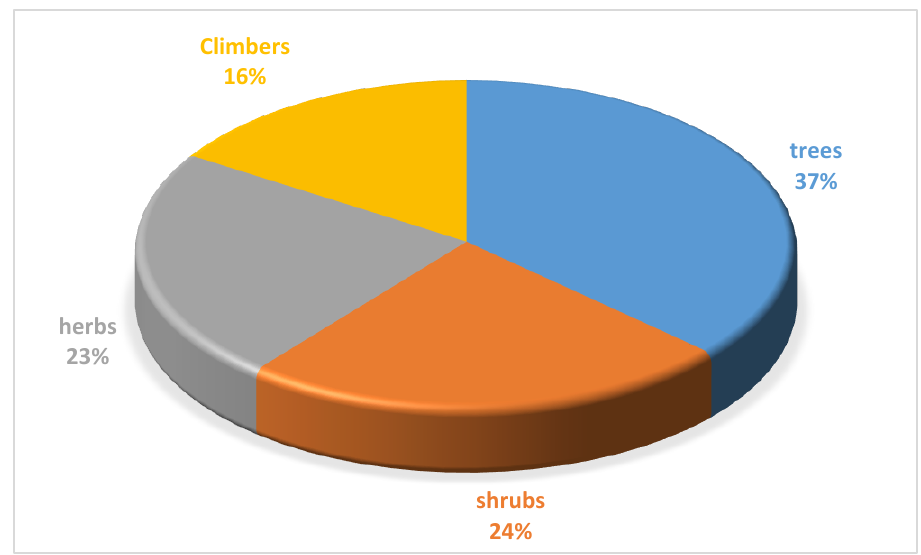
Figure 3. Life-form distribution (%) for the 87 plant species used for managing cough associated with respiratory diseases in Ede South Local Government Area of Osun State, Nigeria.